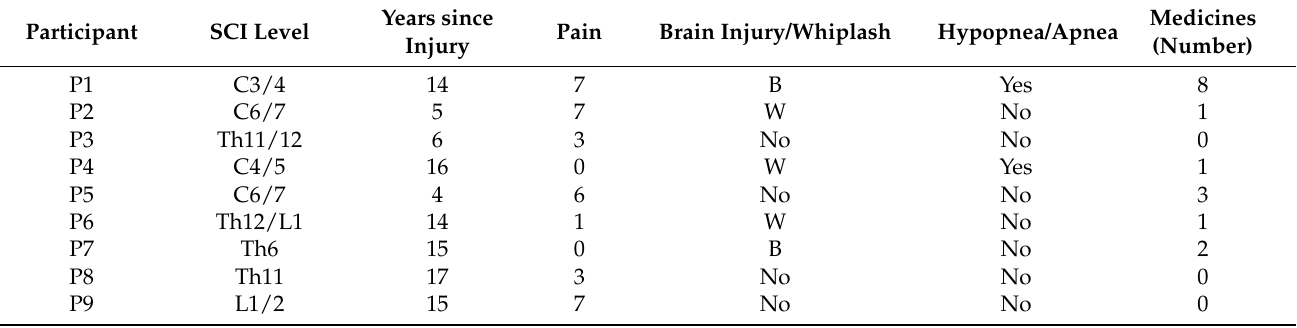
Table 2. Health data of the